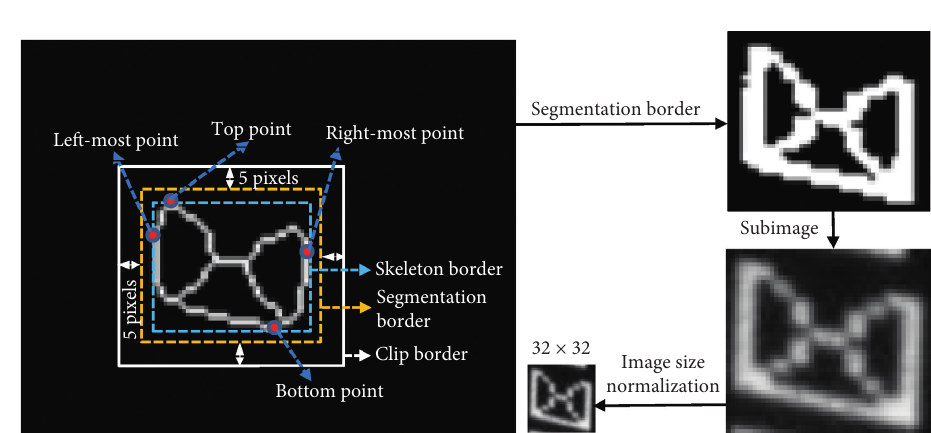
Figure 5: Element extraction and image